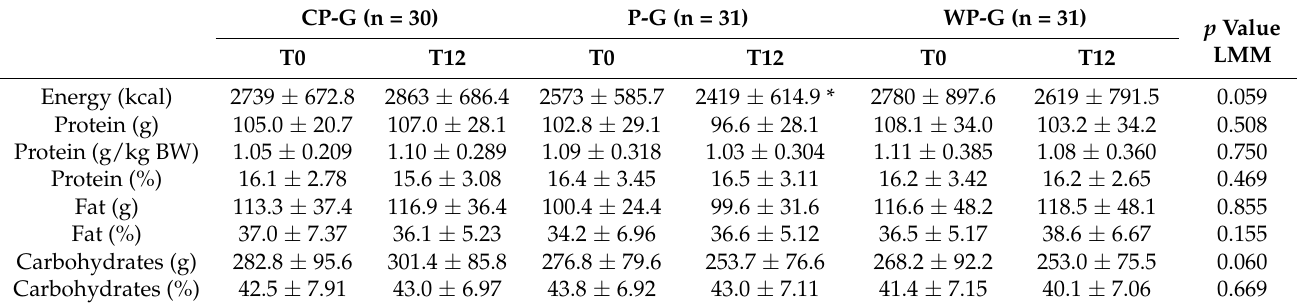
Table 4. Dietary patterns at baseline and following supplementation with collagen peptides, whey protein or